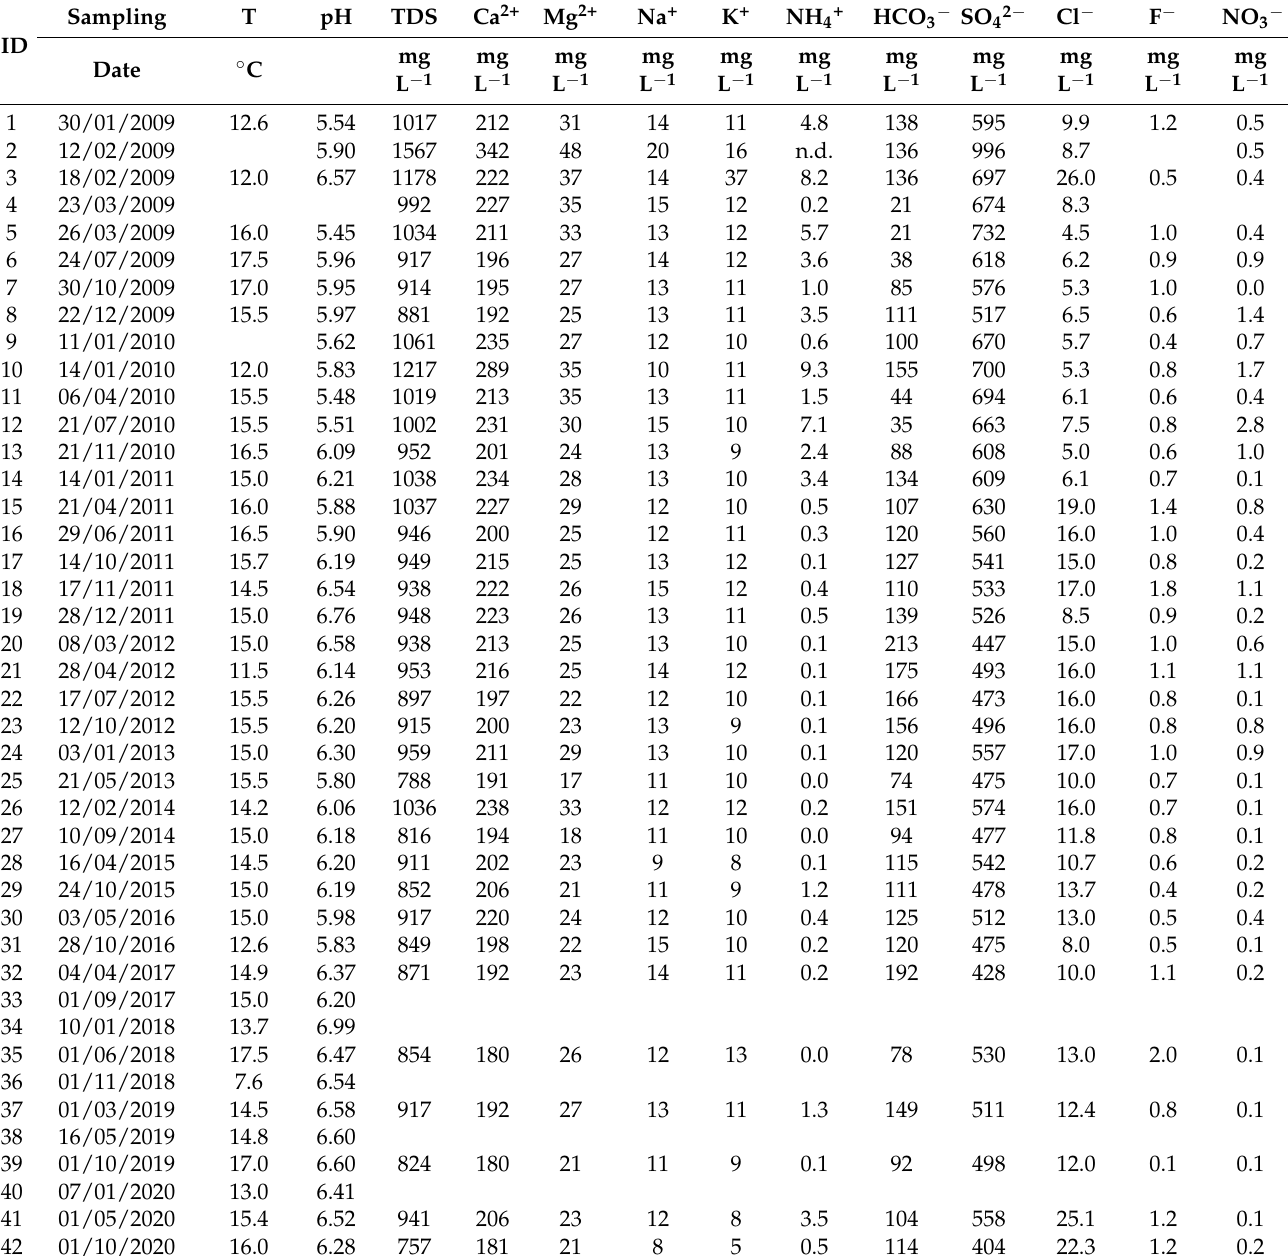
Table 1. Temperature, pH and concentration of the Total Dissolved Solids (TDS), main and minor dissolved species in the Galleria Italia waters. The Identification Numbers (IDs) are those used in the diagrams to refer to the sampling